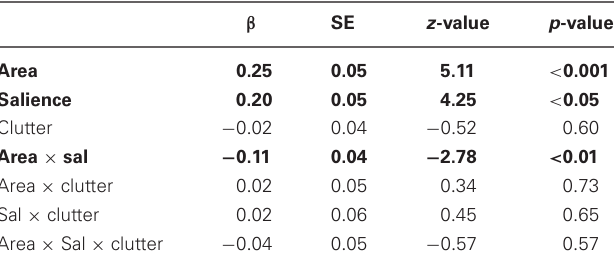
Table 2 | Results of mixed-effects model for predicting proportion of words referencing the target in a description.